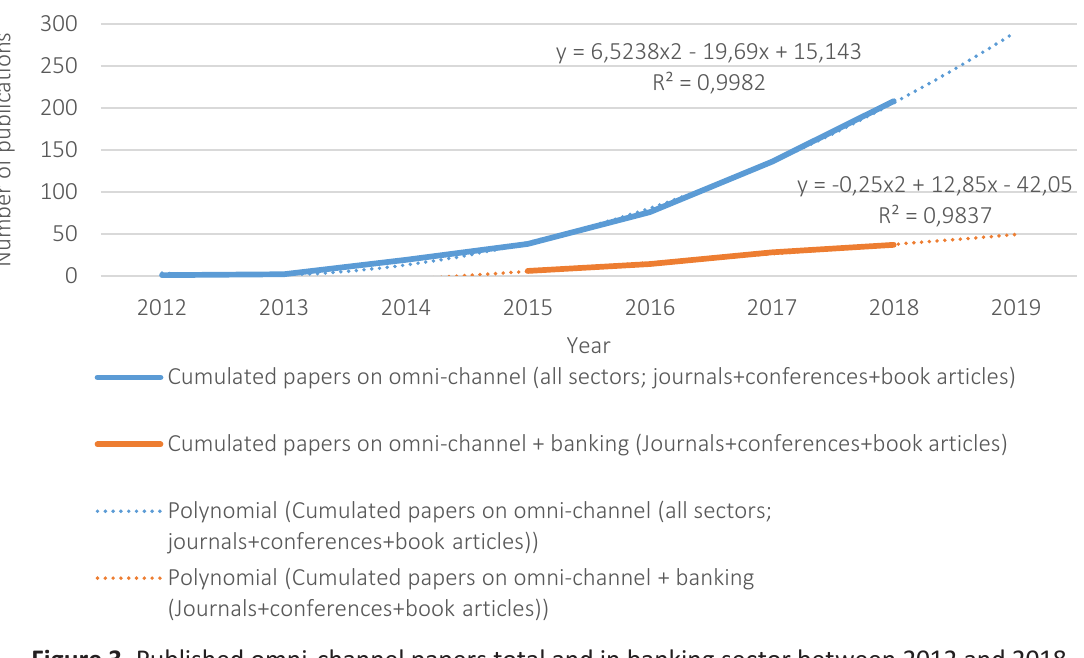
Figure 3. Published omni-channel papers total and in banking sector between 2012 and 2018